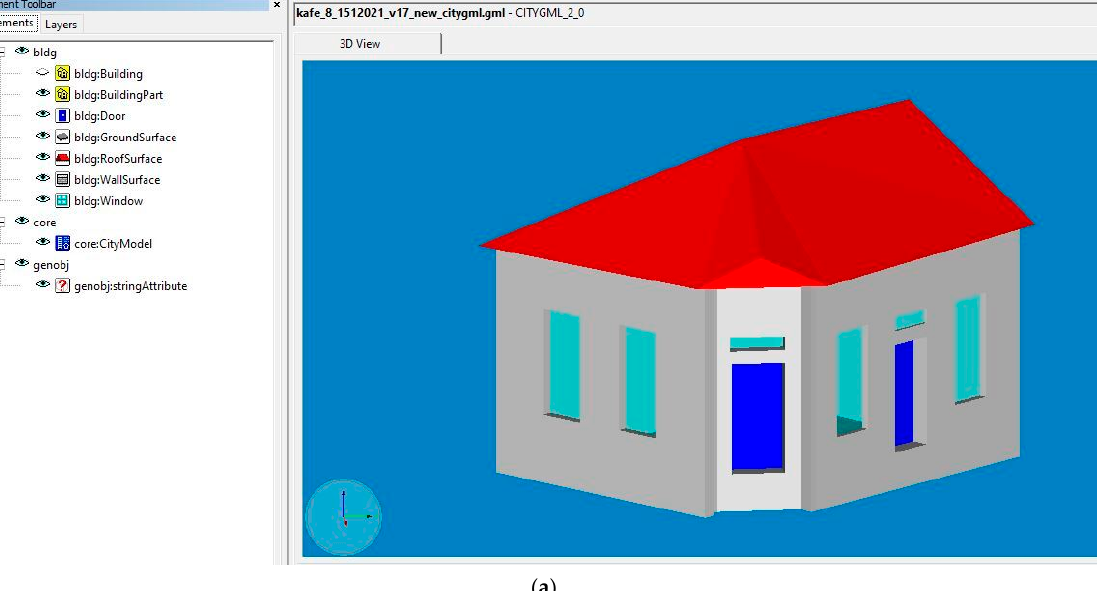
( b ) Figure 10. LOD3 CityGML building models with semantic layers rendered in FZK viewer for ( a ) building A and ( b ) build- ing B. 4. Discussion The objective of this study was the generation of LOD3 building models from 3D point clouds derived by the photogrammetric processing of UAS images, their transfor- mation to CityGML and their enrichment with the seismic damage semantics. For this purpose, manual UAS flights were performed in low flight heights above and around two selected buildings to acquire high-resolution nadir and oblique images. From the present work, it appears that for the design of the 3D model of a traditional building, a minimum quantity of nadir/oblique images is required (less than 100 images) that can be achieved